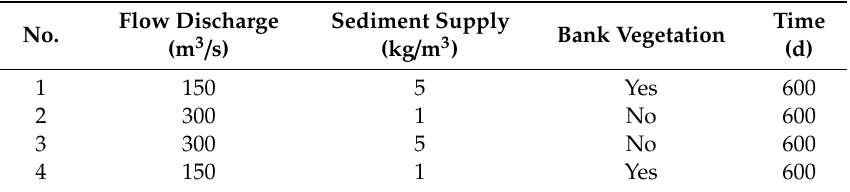
Table 5. The experimental